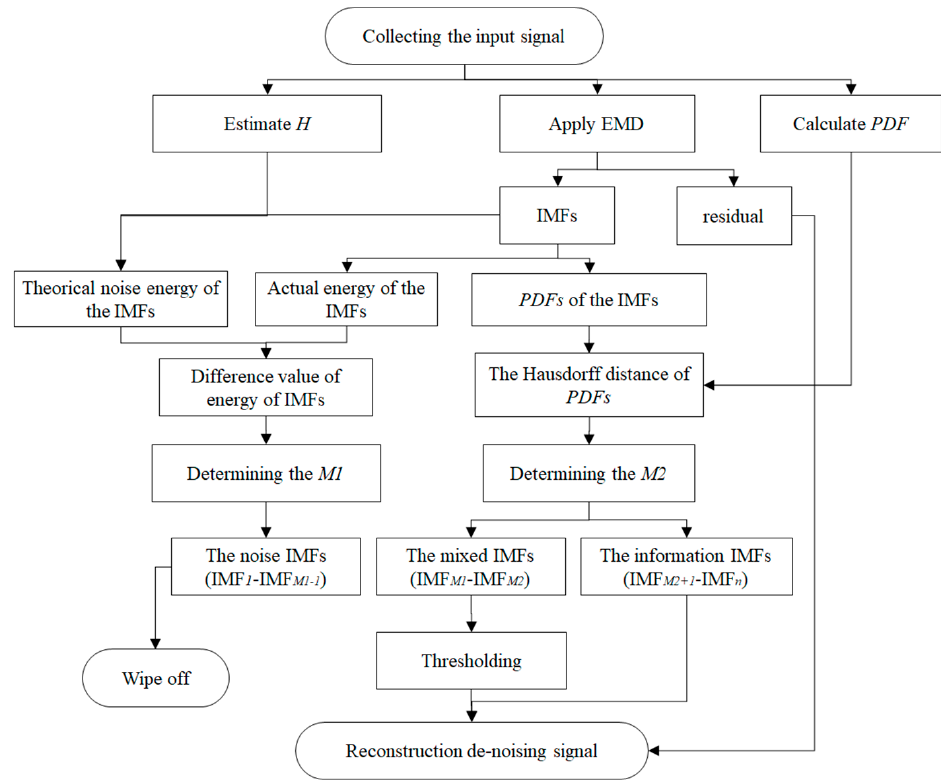
Figure 3. The diagram of the adaptive denoising method. Note: PDF = probability density function.